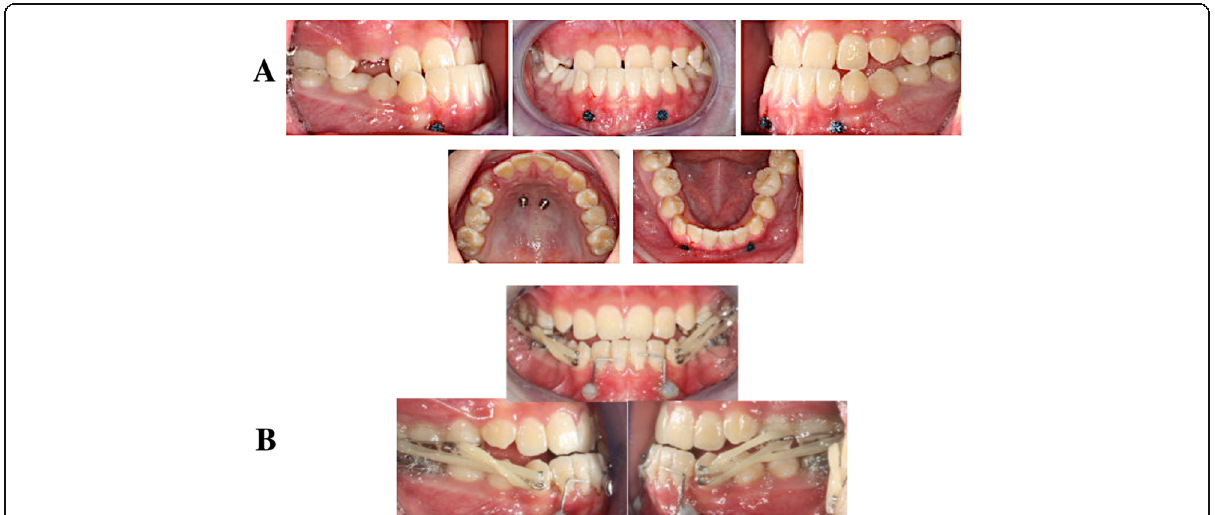
Fig. 1 a Implant placement sites and b appliances loaded with two elastics per side